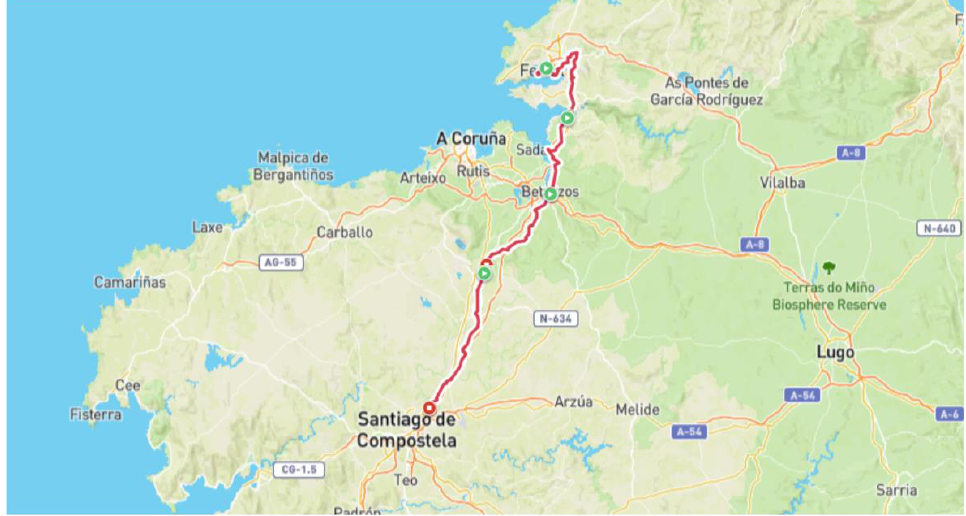
Figure 2. The pilgrim’s path from Ferrol to Formaris and Santiago de Compostela (tracked by the Polar Fitnesswatch).